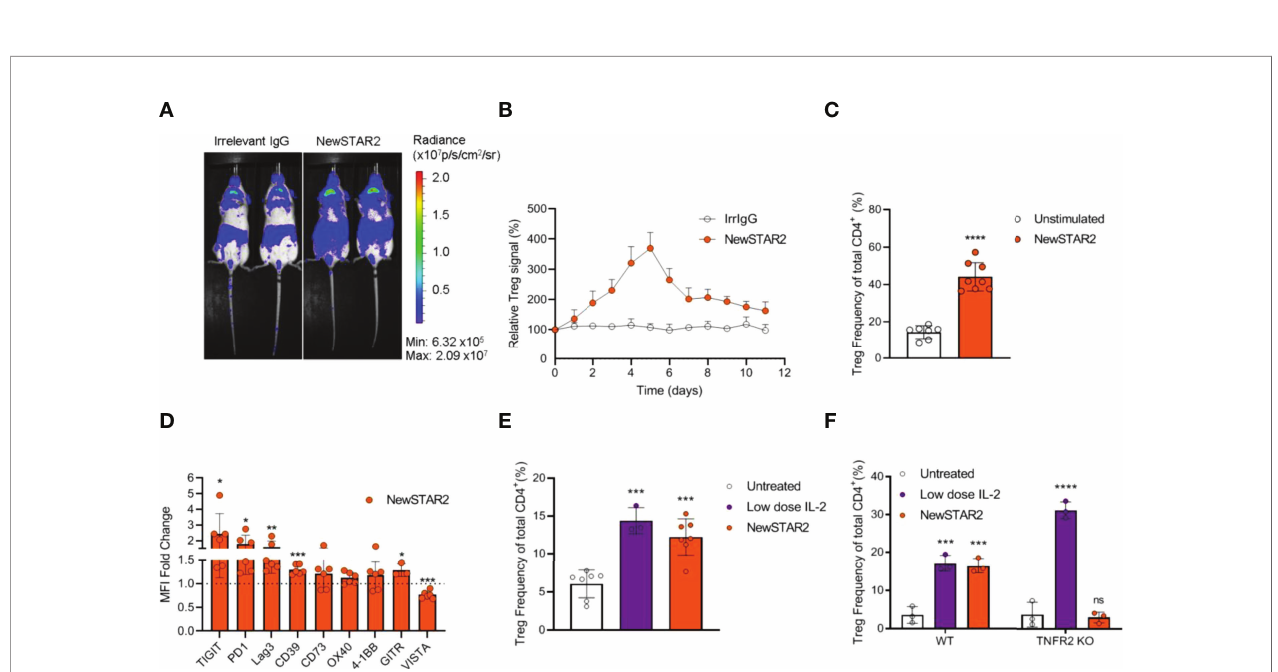
FIGURE 4 | NewSTAR2 expands Tregs in vivo . (A) B6a.FoxP3.LuciDTR female mice were i.p. injected with 140 µg of NewSTAR2 or control IgG1 in PBS on day 0. Pictures from 2 representative mice of each group imaged on day 4 after NewSTAR2 injection. (B) Averaged relative increase in bioluminescence signal derived from luciferase expressing FoxP3 + Tregs compared to the ventral signal of each mouse before treatment (d0). NewSTAR2 n=6; Irrelevant IgG1 n=8. (C) Relative CD4 + FoxP3 + Treg frequencies in spleens isolated from mice on day 4 after stimulation measured with fl ow cytometry; n=5/group. (D) MFI fold change of distinct Treg markers normalized to the MFI of untreated Tregs. n=6. (E) Relative Treg frequencies within splenic CD4 + T cells 4 days after in vitro treatment; untreated n=7; low dose IL-2 n=3; NewSTAR2 n=7. (F) Relative Treg frequencies in CD4 + T cells from B6 or B6.TNFR2-KO splenic T cell cultures 4 days after in vitro stimulation; n=3. Data are shown as mean +/- SD, *p ≤ 0.05, **p ≤ 0.01, ***p ≤ 0.001, ****p ≤ 0.0001; ns, not signi fi cant; two-tailed unpaired Student ’ s t-test was applied for (A – D) . ANOVA was applied to compare untreated cells against NewSTAR2 and low dose IL-2 shown in (E, F) .